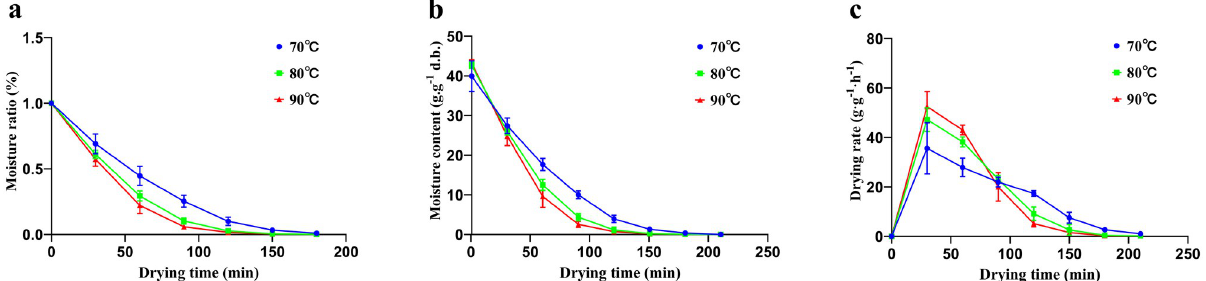
Fig 1. Drying characteristics of AR pieces. (a): Moisture ratio. (b): Moisture content. (c): Drying rate. Data are represented as the mean ± standard deviation of three independent experiments.